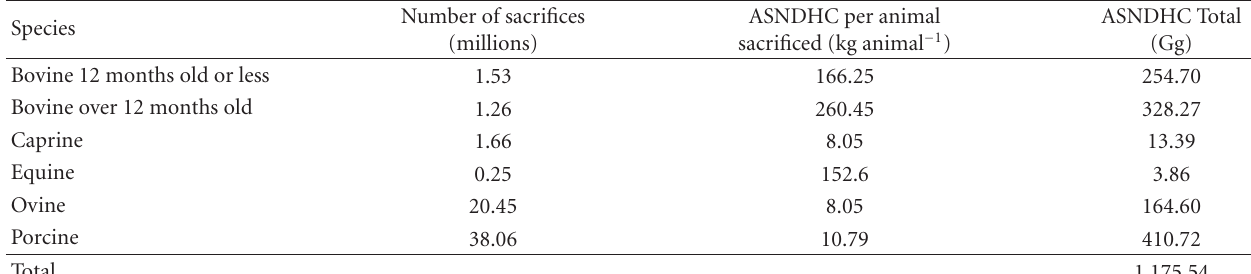
Table 2: Summary of the ASNDHC generated per animal species in Spanish slaughterhouses in 2005.